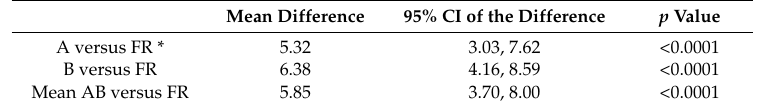
Table 2. Mean difference from paired samples t-test for the Mediterranean Diet and Culinary